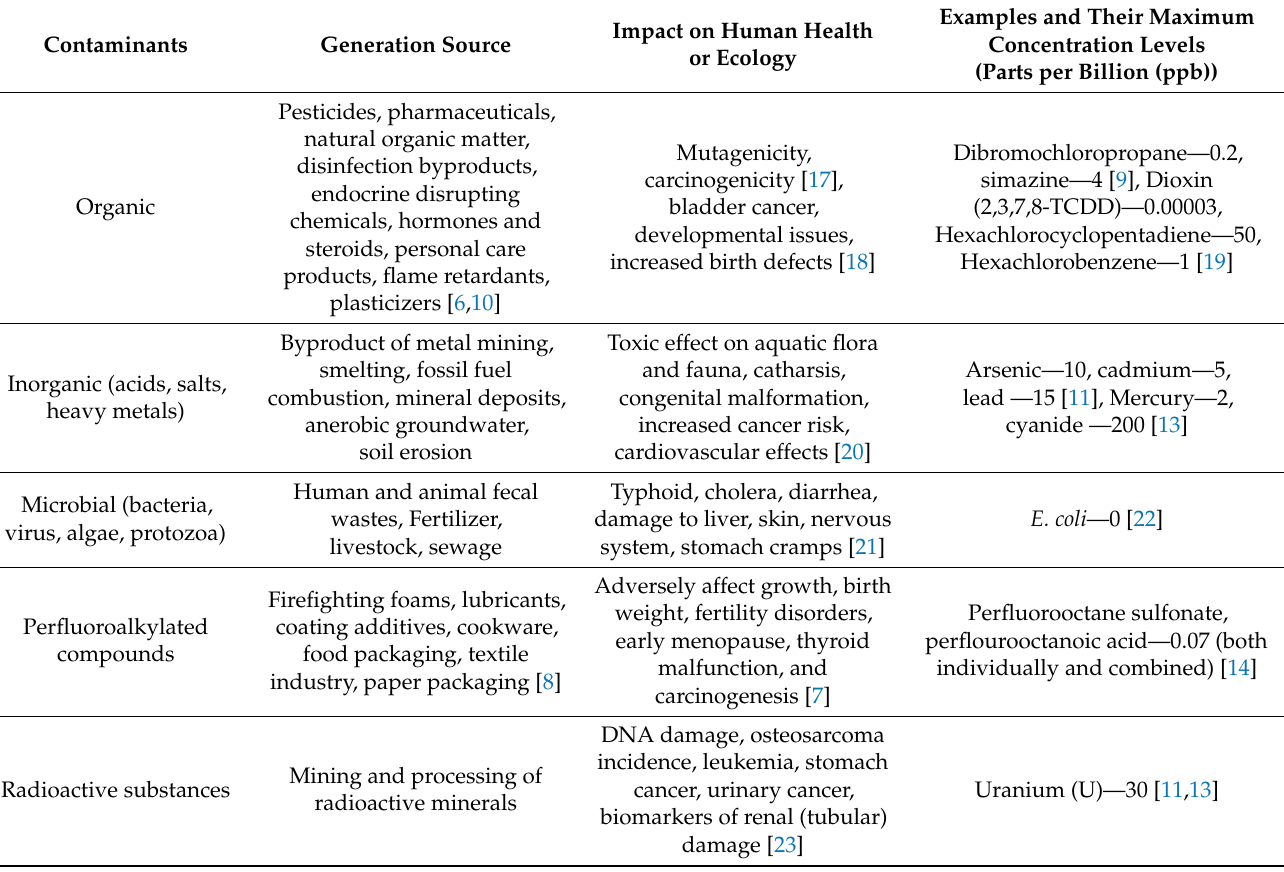
Table 1. Different types of contaminants and their associated adverse health effects, examples, and maximum concentration